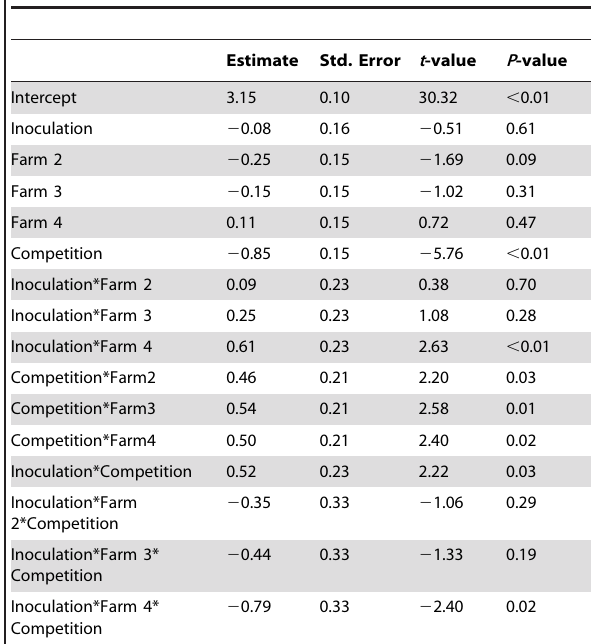
Table 2. Linear model testing effect of inoculation, competition and farm on shoot biomass of Triticum aestivum in the feedback